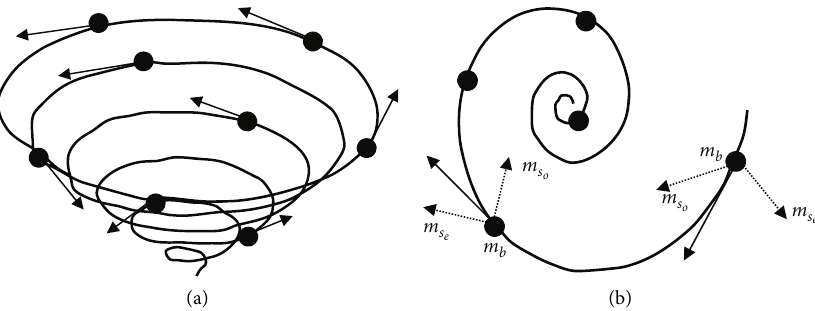
Figure 4: Motion of a particle on a logarithmic spiral. (a) General view of the movement and (b) the direction of the movement according to the body, soul even, and soul odd